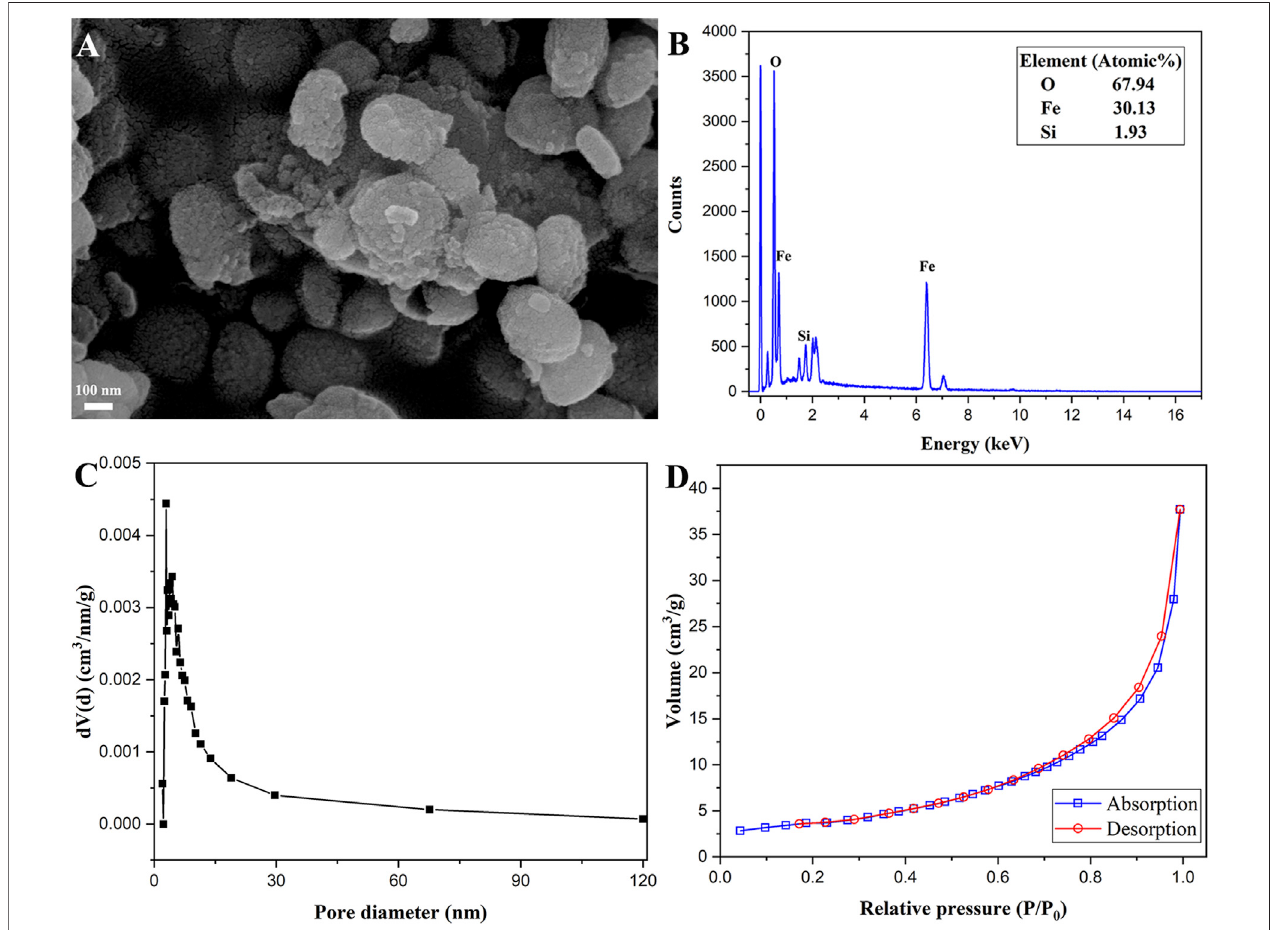
FIGURE 3 | SEM morphology (A) , EDS spectrum (B) , the chart of pore diameter distributions (C) , and N 2 adsorption and desorption diagram (D) of α -Fe 2 O 3 /